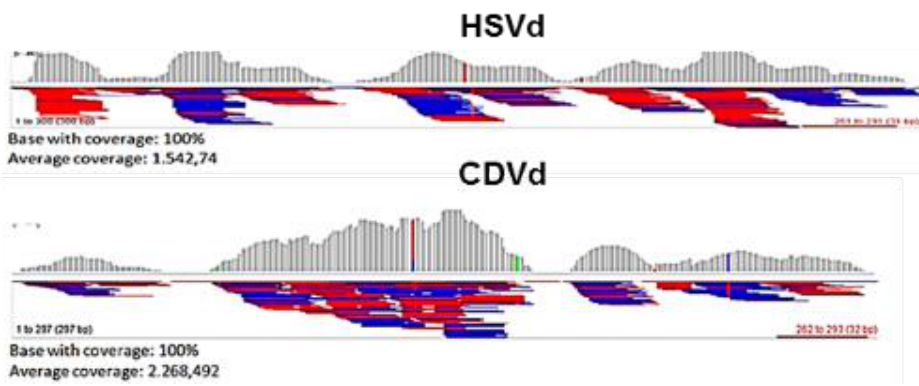
Figure 9. Genome reconstructions of the hop stunt viroid (HSVd) and citrus dwarfing viroid (CDVd) by alignment of the siRNA reads of HU-PSTS library with reference sequences.